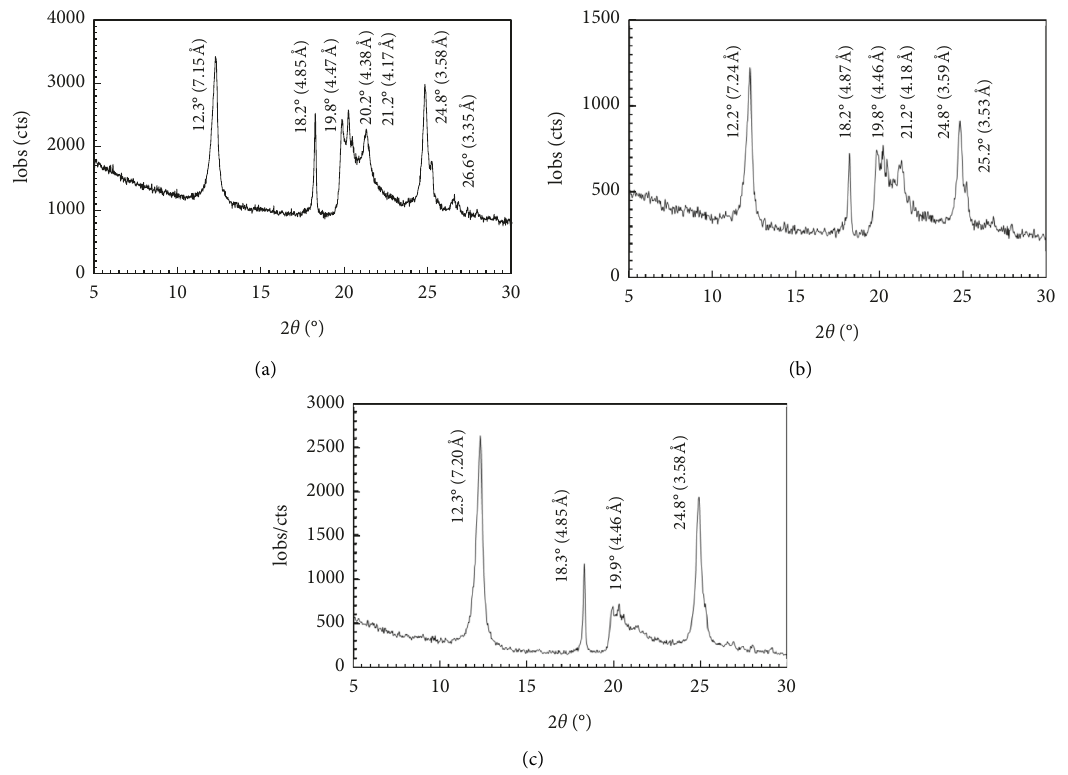
Figure 2: XRD curves of S-4 (Wuming). (a) Original sample. (b) Sample less than 75 μ m. (c) Sample less than 2 μ